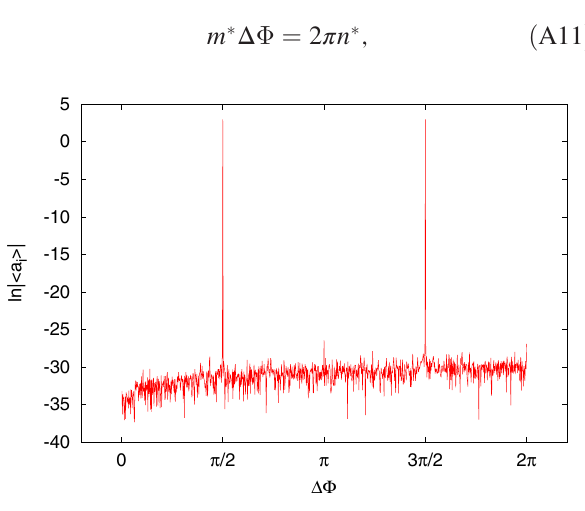
FIG. 9. Averaged cumulated numerical noise h a ~ Z 0 initializations of following Eq. (A12). Peaks appear at phase ij advances Δ Φ ¼ π = 2 , and Δ Φ ¼ 3 π = 2 .